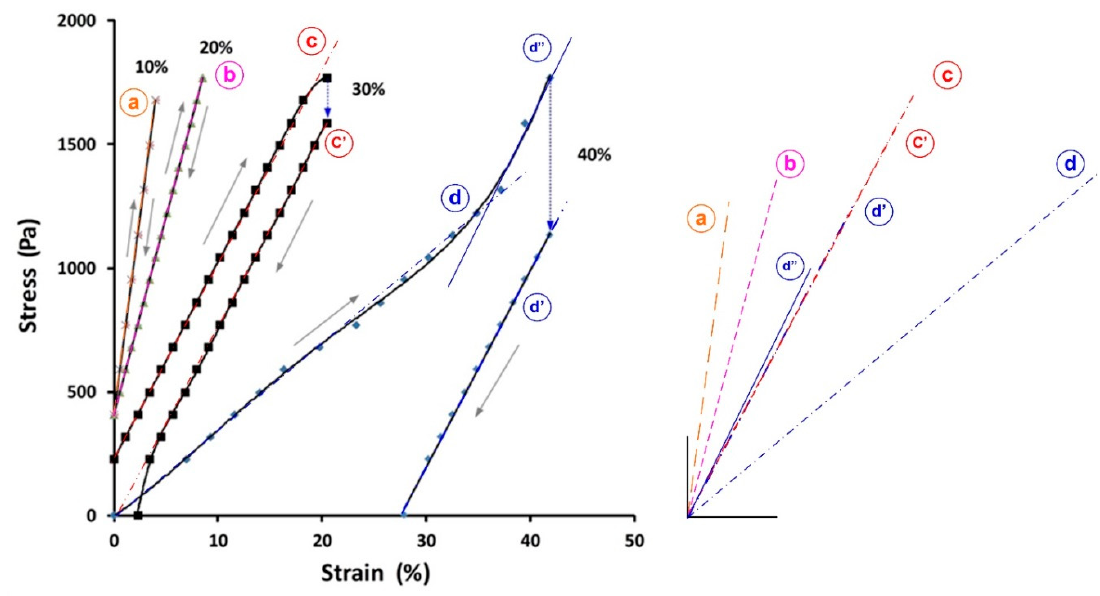
Figure 5. Stress versus strain relationships in a loading/unloading cycle (in a quasi-static manner) ( left ) (black lines are data fitting of the slopes) and comparison of the slopes in loading/unloading ( right ).